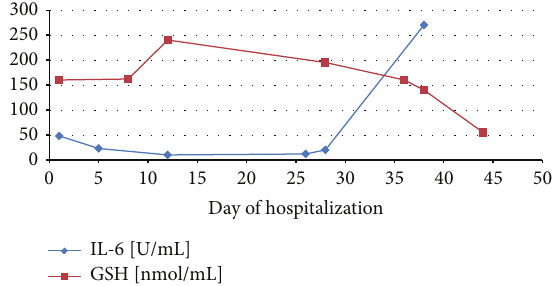
Figure 1: Dynamics of the changes in GSH level and IL-6 concen- tration in patient 6 with acute